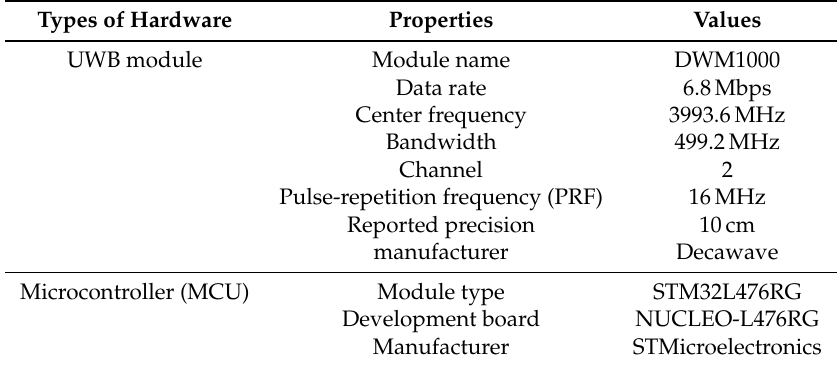
Table 1. Configurations of the primary hardware used in the experimental